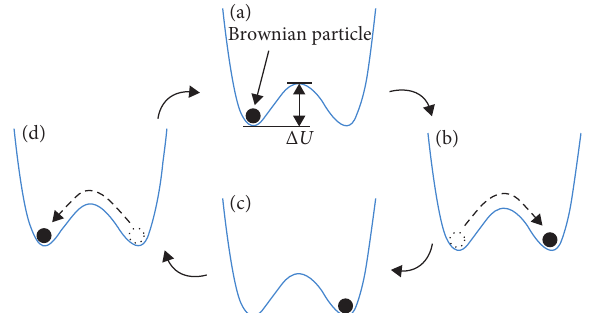
Figure 1: The motion diagram of the Brownian